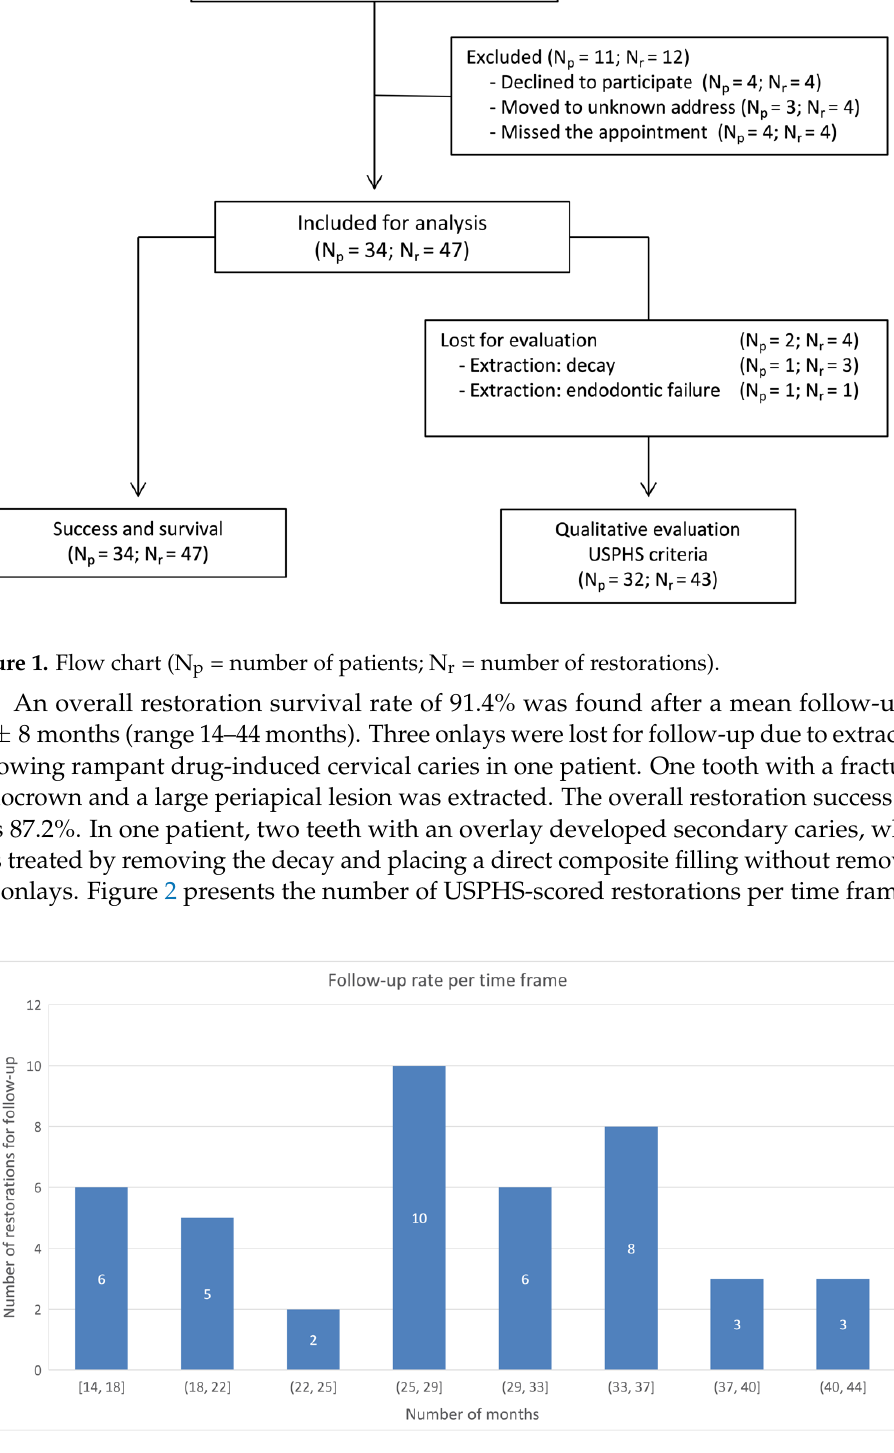
Table 3. Distribution of involved teeth ( N = 43) in the study population.